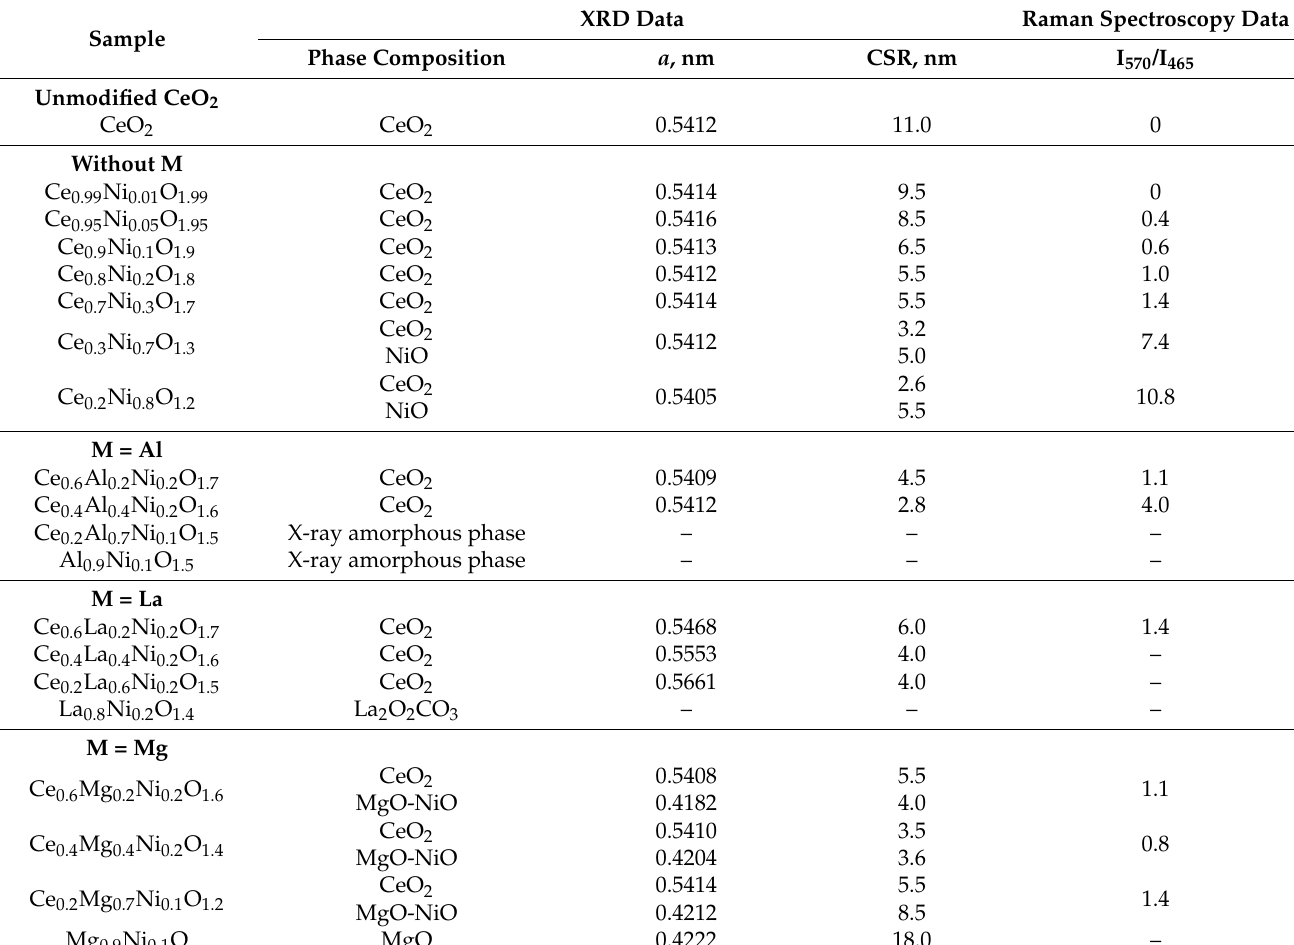
Table 2. Phase composition and structural properties of (CeM) 1 − x Ni x O y